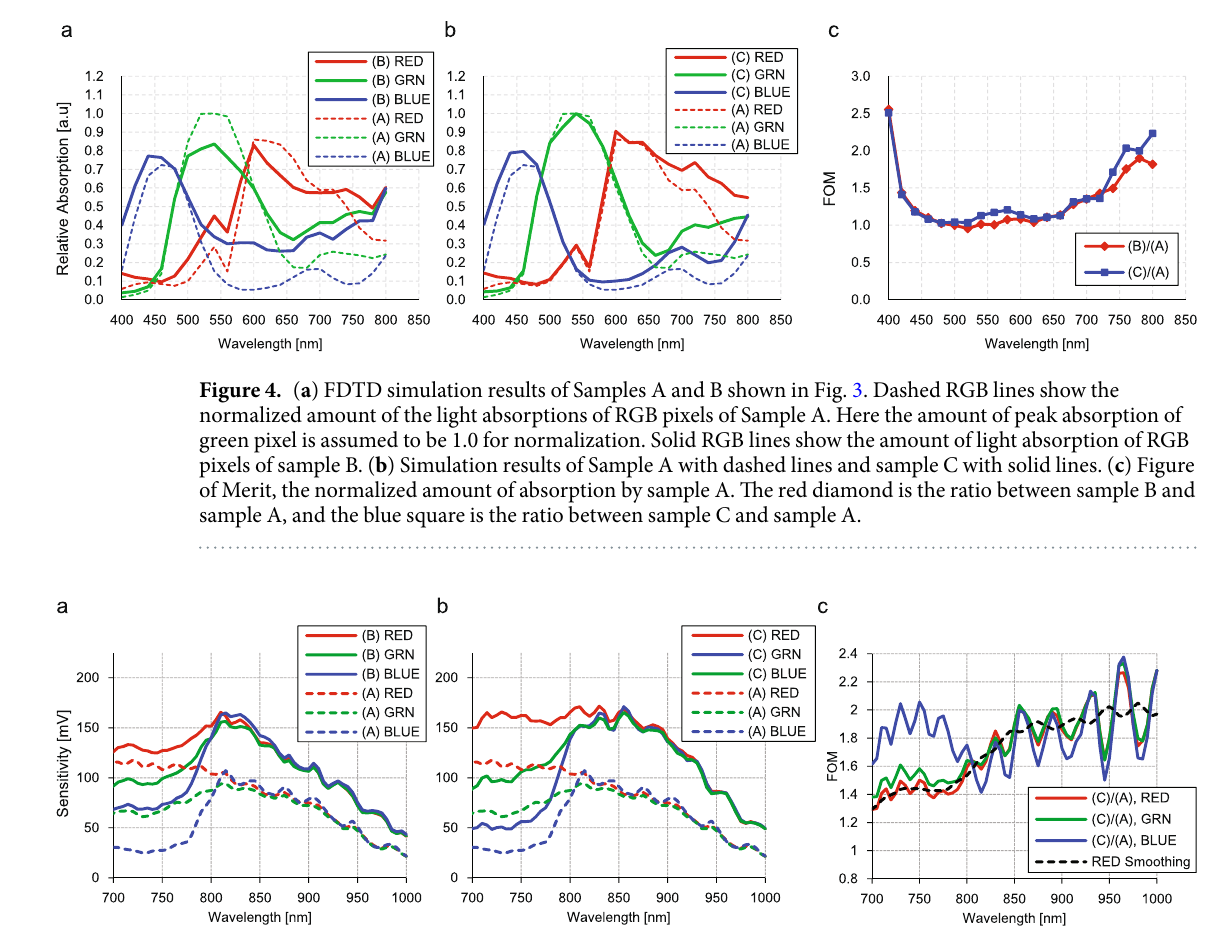
Figure 5. ( a ) Measured spectral sensitivities of the prototype samples A and B. Dashed lines are the sensor sensitivity of sample A for reference. Solid lines are those of sample B with 400 nm pitch IPA structure. ( b ) Dashed lines are data of sample A, and solid lines are those of sample C with the IPA structure and DTI. ( c ) Normalized sensor sensitivities of sample C divided with sample A sensitivities. RGB colors correspond to the RGB pixels. The black dashed line is the running average over 50 nm of the red pixel to make quite the ripple due to Fabry-Perot interference of